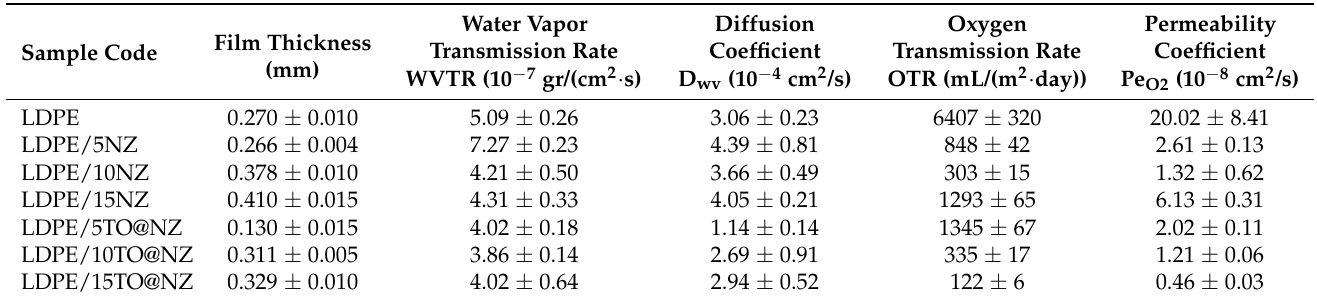
Table 3. Water vapor transmission rate (WVTR), water vapor diffusion coefficient (D wv ), oxygen trans- mission rate (OTR), and oxygen permeability (Pe O2 ) values for all LDPE/xNZ and LDPE/xTO@NZ films, as well for pure LDPE